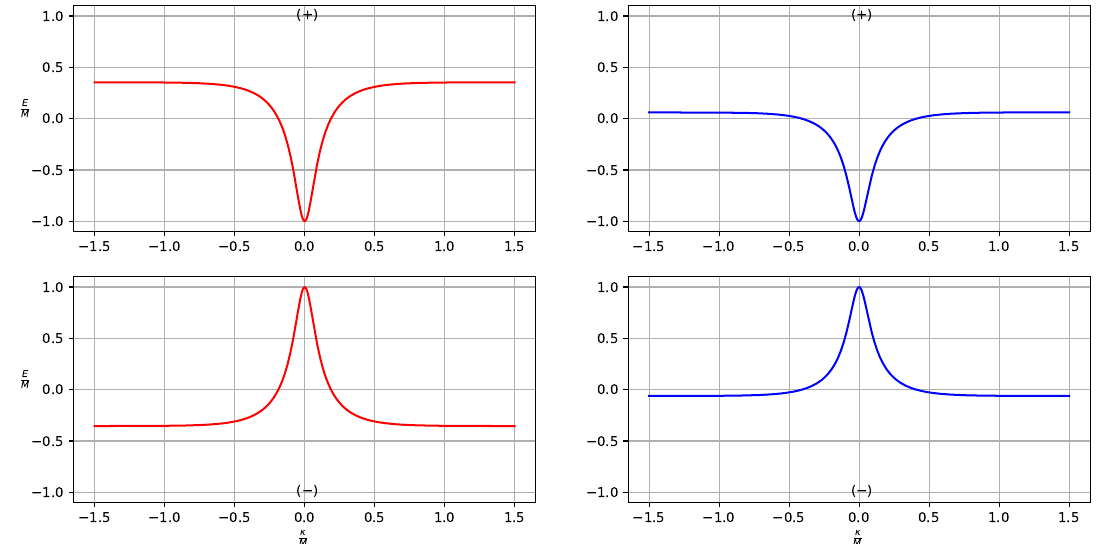
Figure 25 . E vs κ for θ 0 = 2 π/ 3 . The parities of the bound states are indicated as ( ± ) . These M M plots show in-gap states ( | E | < 1 M